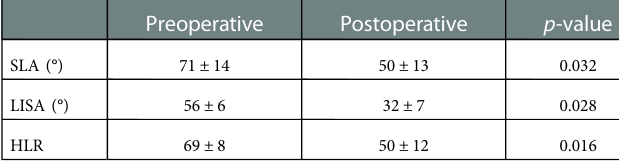
TABLE 2 Preoperative and postoperative radiographic data of patients with humpback